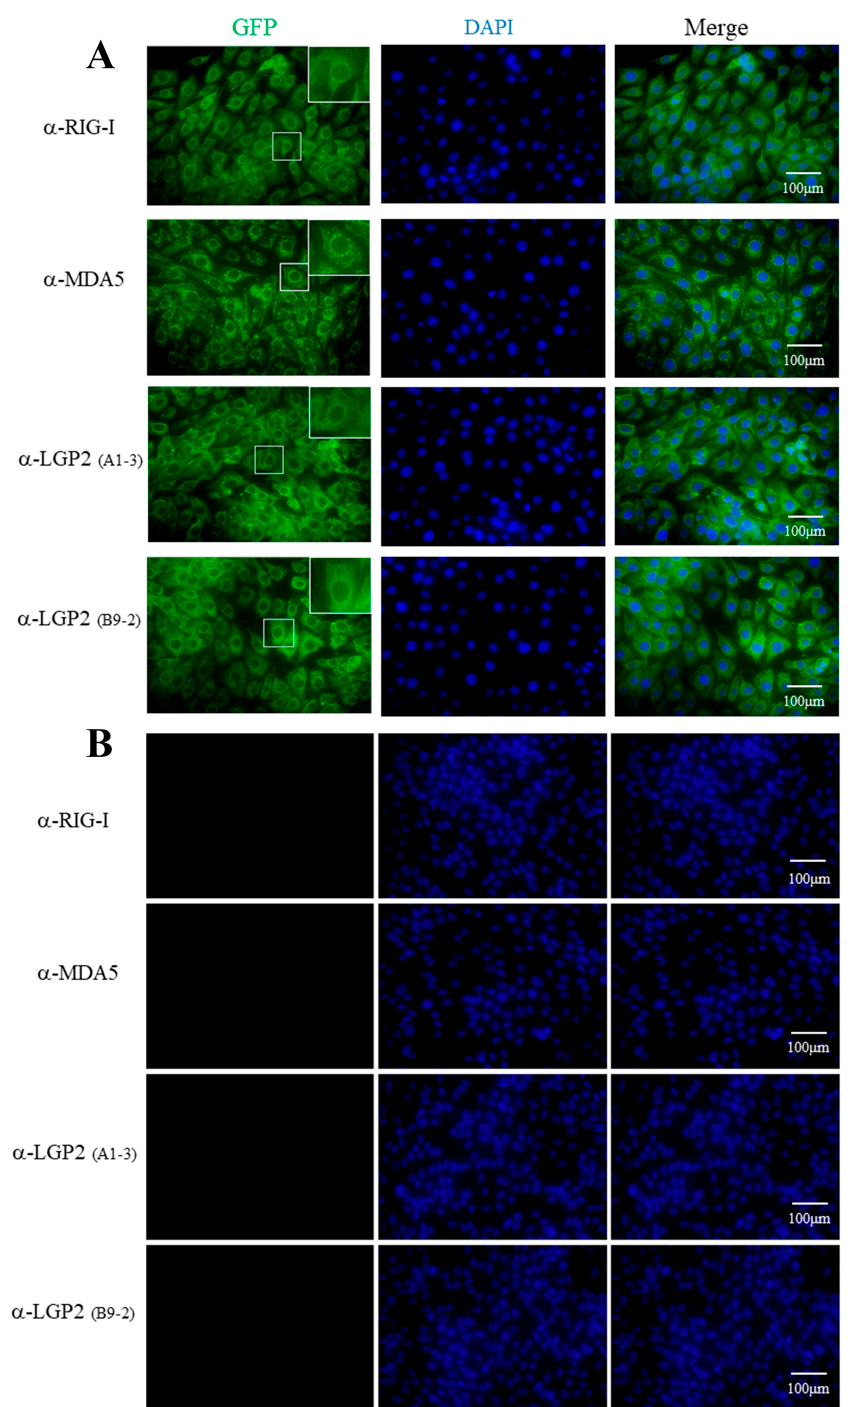
Figure 3. The cellular localizations of porcine RLRs identified by RLR mAbs in immunofluorescence assay (IFA). The PAM cells in 15 mm glass bottom cell culture dishes were grown to 70–80% and stimulated with 500 IU/mL human IFN- β for 8-12 h ( A ) or without stimulation ( B ). The cells were fixed, permeabilized and incubated with pRIG-I, pMDA5 and pLGP2 ascite mAbs (1:200 each) at 4 ◦ C overnight. Then, the cells were stained with secondary antibody Alex Fluor TM 488 Donkey anti-Mouse Antibody (1:800) and counterstained with DAPI. The cellular localizations of pRIG-I, pMDA5 and pLGP2 in the PAM cells were examined under a fluorescence microscope. The boxed areas are magnified and shown on the upper right corners of each panels in ( A ). There was no reaction of non-stimulated PAM cells with RLR mAbs ( B